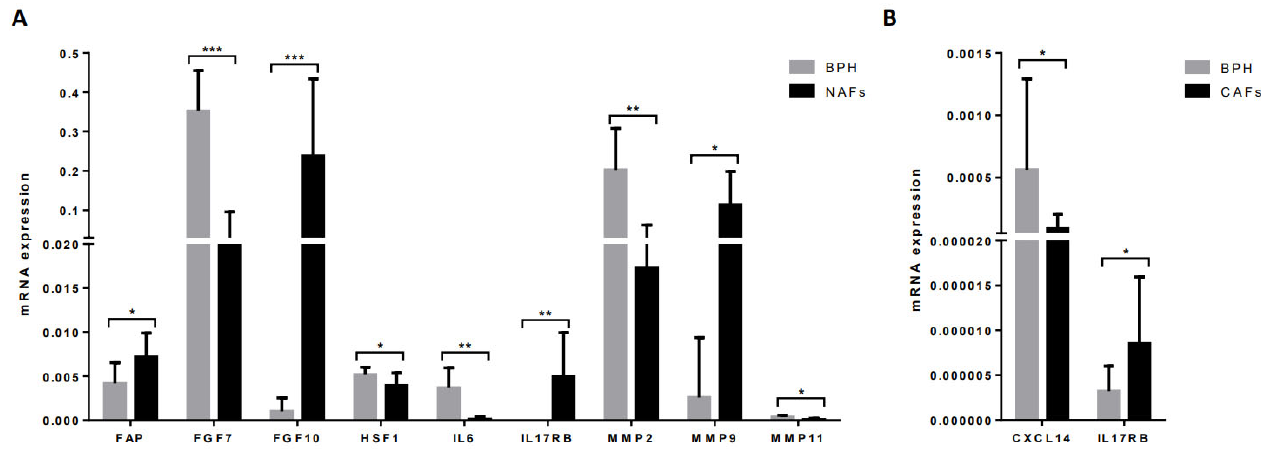
Figure 4. Gene expression of stromal factors by ( A ) NAFs or ( B ) CAFs from prostate tumors com ‐ pared with fibroblasts from benign prostate hyperplasia (BPH). * p ≤ 0.05; ** p < 0.01; *** p < 0.001.